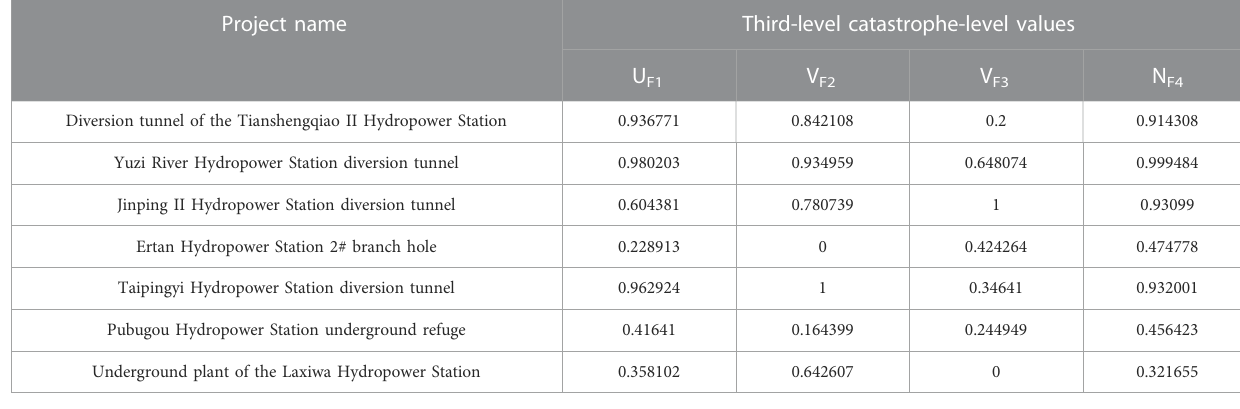
TABLE 7 Third-level catastrophe-level values of each